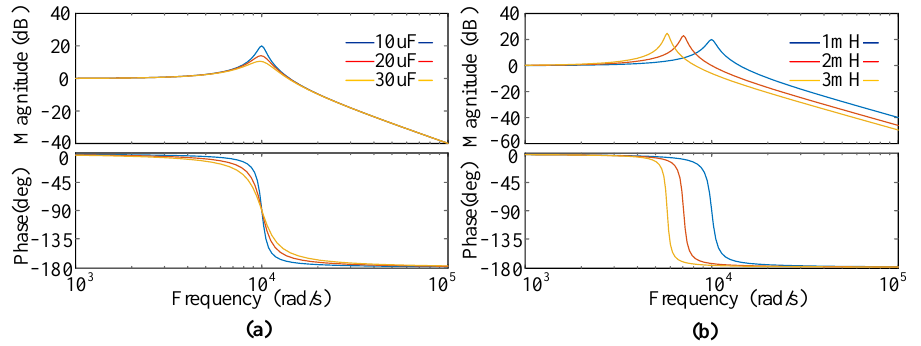
Figure 7. Bode plot of CL filter without damping: ( a ) L = 1 mH, 10 μ F < C < 30 μ F, ( b ) 1 mH < L < 3 mH, C = 10 μ F.